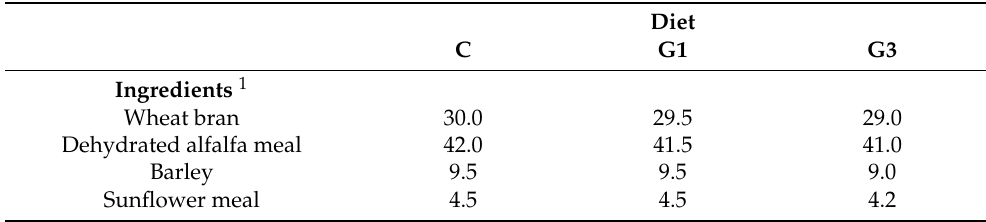
Table 1. Formulation and chemical composition (as fed) of control (C) and experimental diets supplemented with 1% (G1) and 3% (G3) Goji